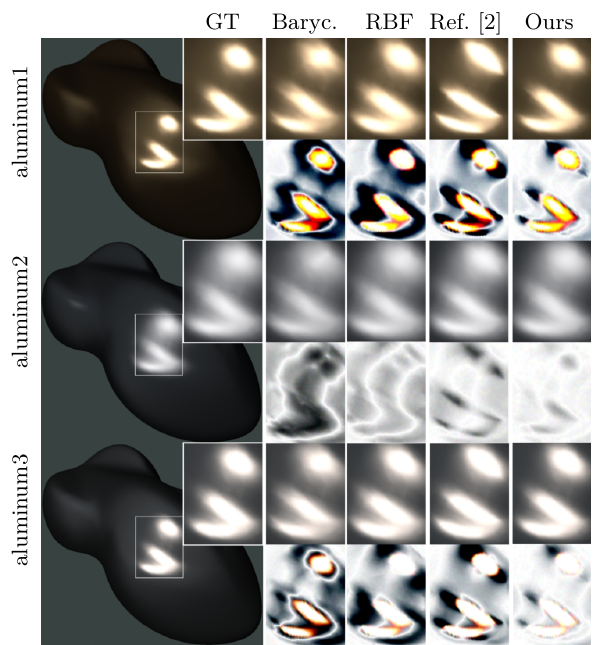
Fig. 15 Renderings of three specular anisotropic materials using different sampling approaches and 8911 samples, compared with the ground truth (GT). The difference images are